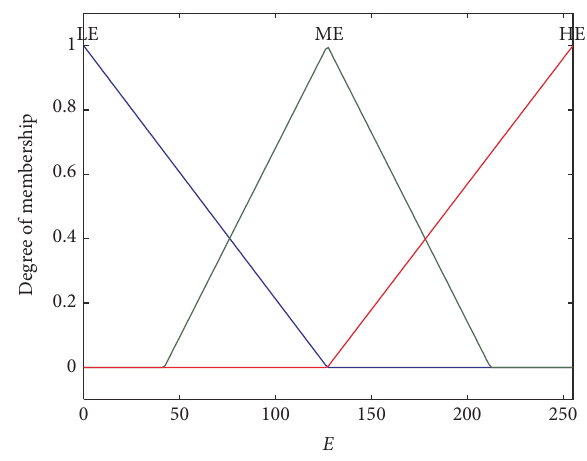
Figure 2: Membership functions for output 𝐸